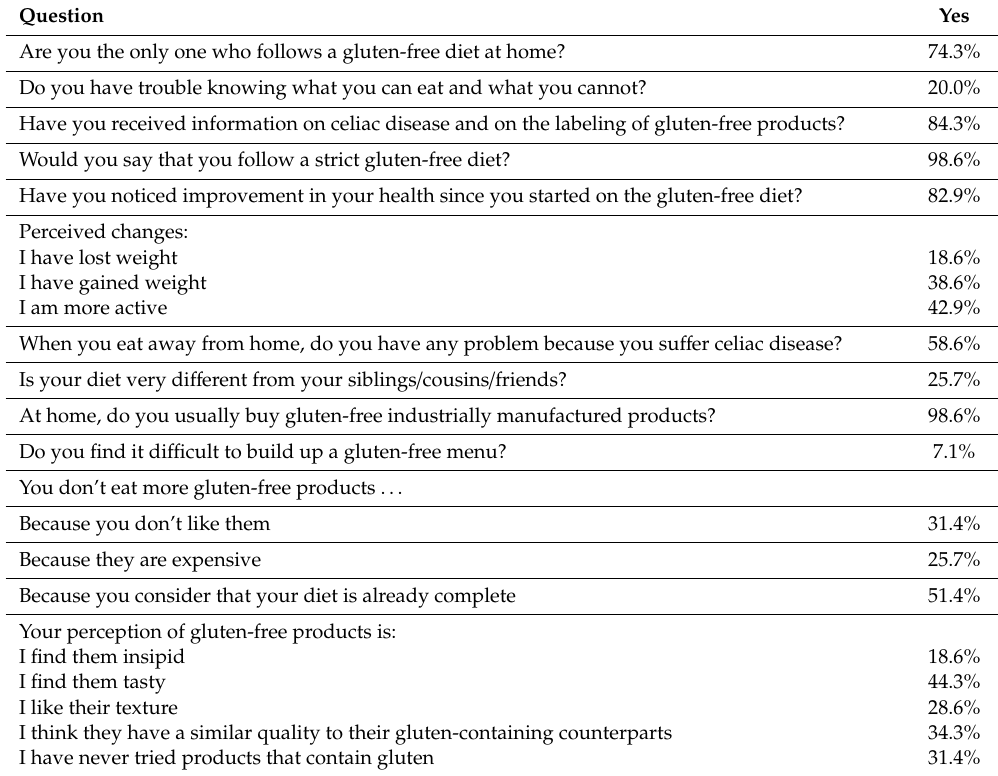
Table 1. Subject perception of commercial gluten-free products in celiac children and